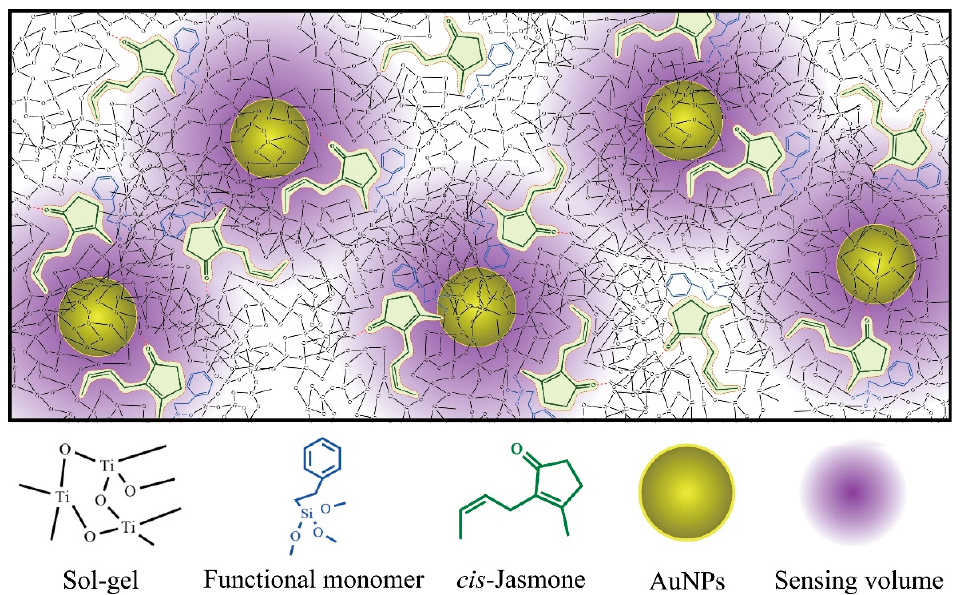
Figure 11. Scheme of the MIP-coated gold nanoislands with functional monomers for cis-jasmone Figure 11 . Scheme of the MIP ‐ coated gold nanoislands with functional monomers for cis ‐ jasmone vapor detection. (Reprinted with permission of [90] Copyright © 2018, Elsevier vapor detection. (Reprinted with permission of [90] Copyright © 2018, Elsevier B.V.).